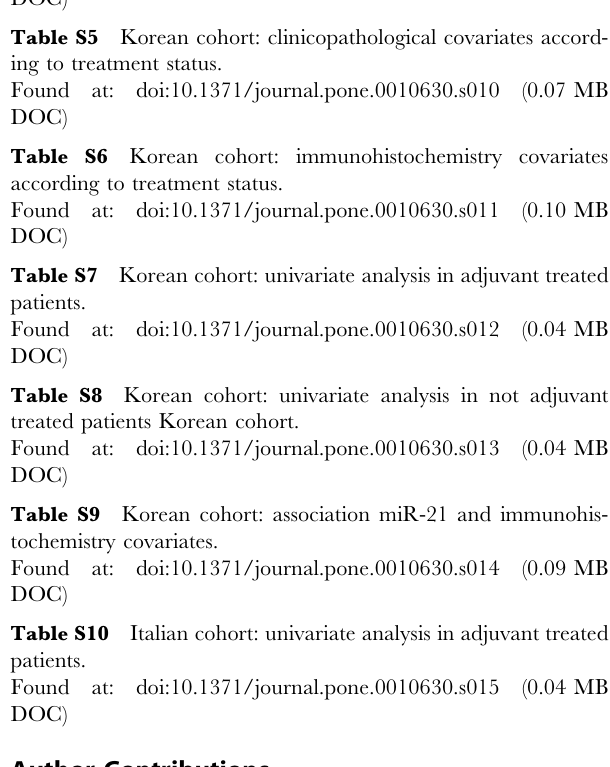
Table S4 Univariate analysis Korean cohort.